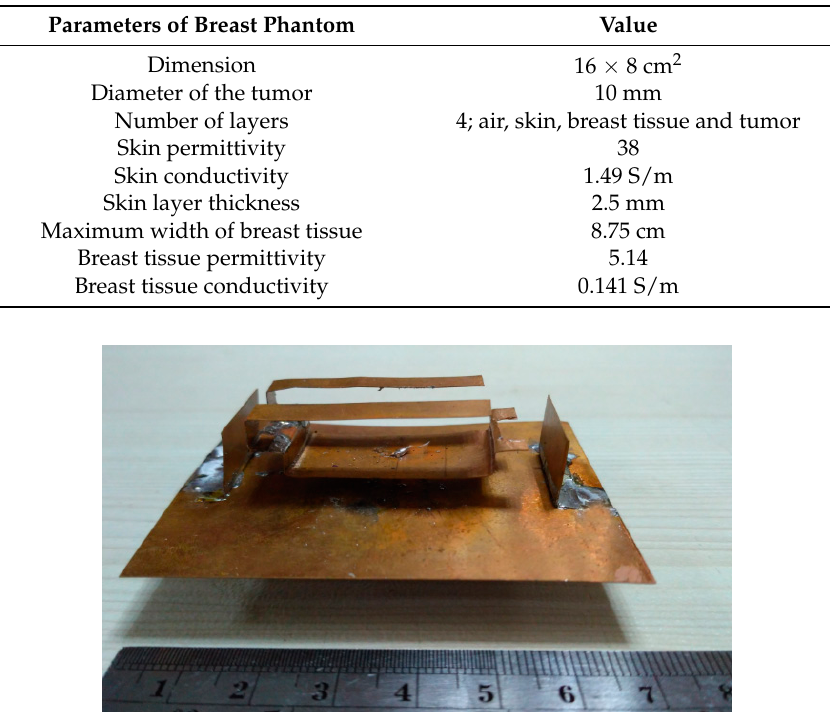
Table 1. Breast phantom specification.